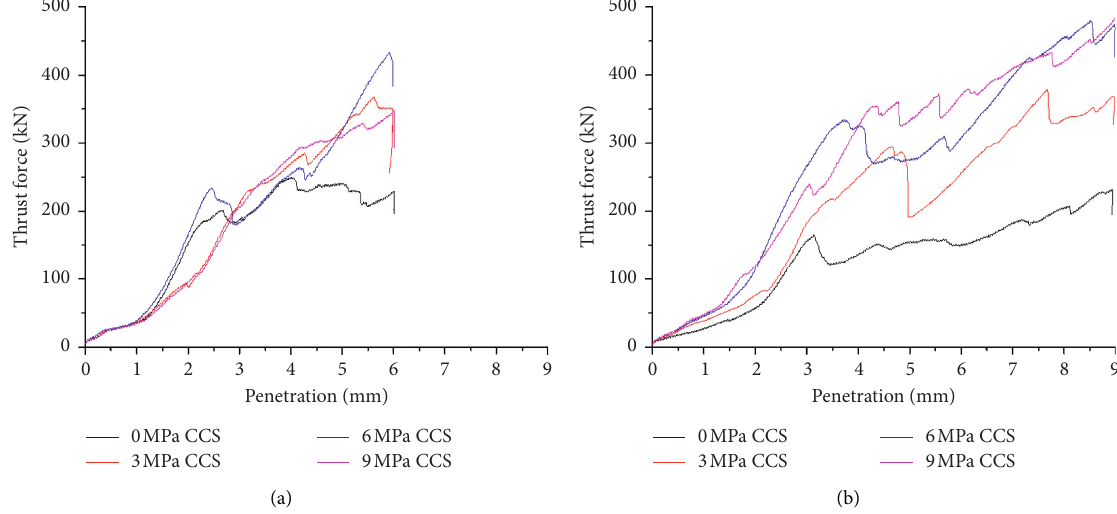
Figure 8: Thrust cutting force evolution patterns under the CCS disc cutter. (a) Ultimate penetration � 6mm; (b) ultimate penetration � 9mm.